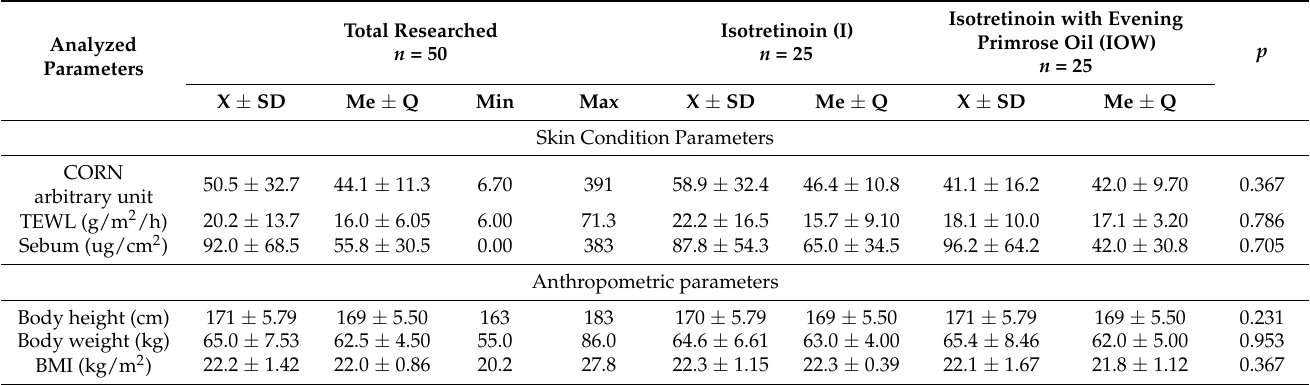
Table 2. CORN, TEWL and sebum levels in group I and IOW before the study